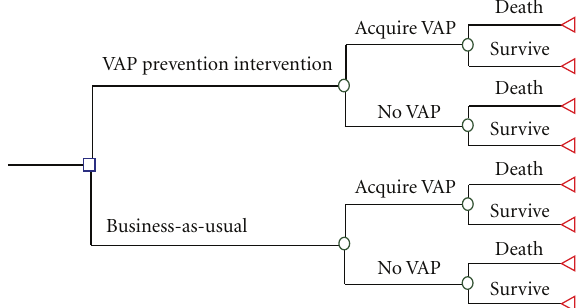
Figure 1: Analysis framework for comparing the QI intervention to